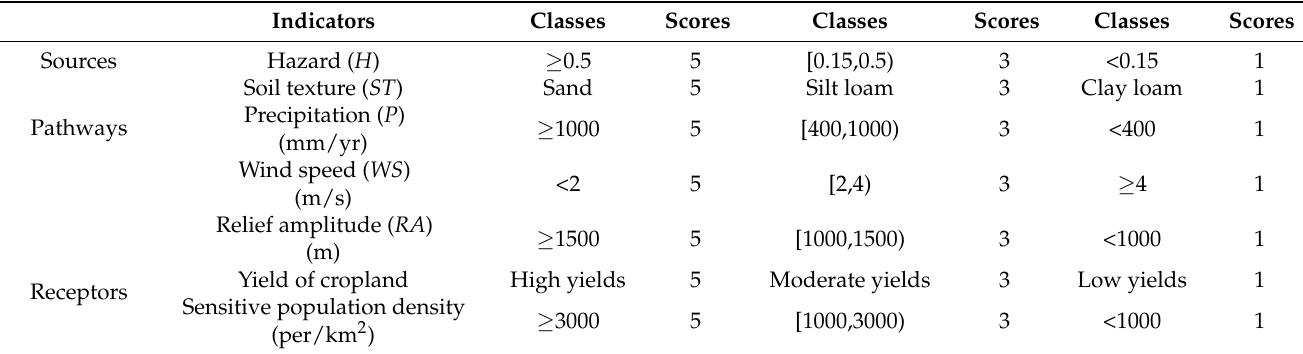
Table 3. Scores used for indicators normalization in the case